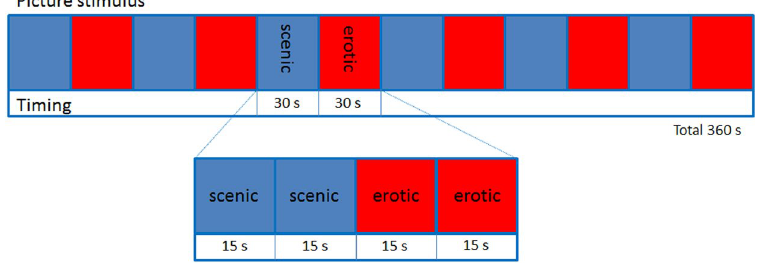
Figure 5. Erotic picture stimuli task. The blue bars represent the scenic pictures, and the red bars represent the erotic pictures. Subjects first saw two random scenic pictures for 15 s each (blue pictogram). Then, the participants saw two random erotic pictures, also for 15 s each (red pictogram). These two sections were counted as one set, and there were six sets in the whole paradigm for a total of 360